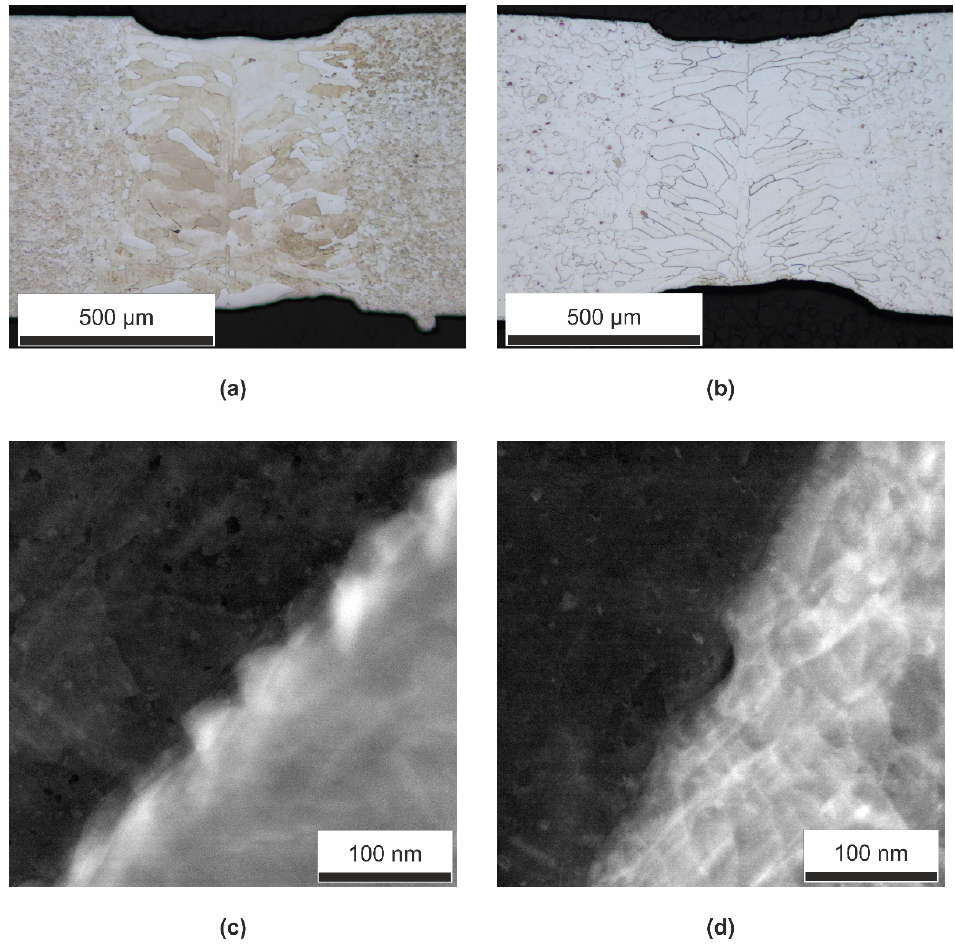
Figure 2. Microstructural evolution of laser-welds. Light microscopy images of ( a ) AISI 430 and ( b ) AISI 430Ti. ( c , d ) STEM-images of investigated grain boundary regions following FIB-extraction.